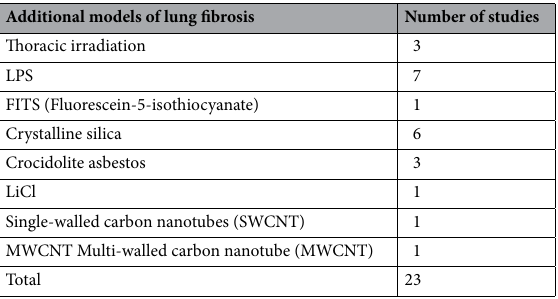
Table 3. Non-bleomycin models of lung fibrosis in mice. 21 of 23 non-bleomycin models were used in addition to the bleomycin model in the same studies; in the case of Lox1 and Timp1 genes, only non-bleomycin models were